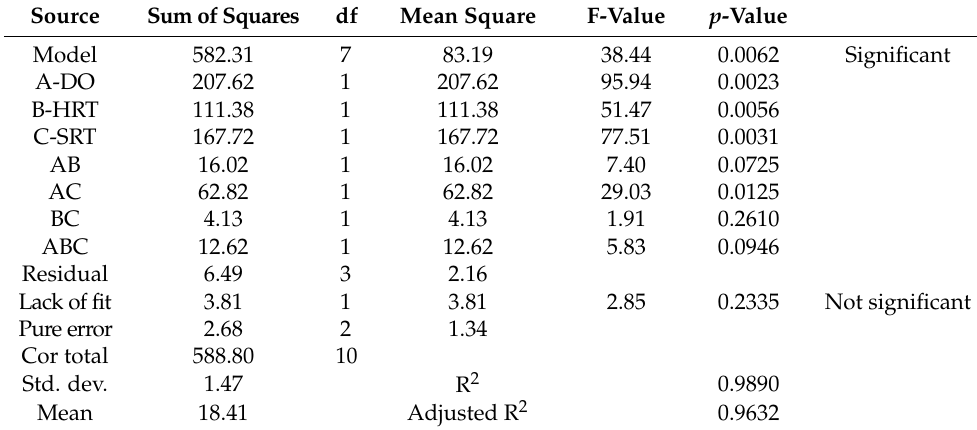
Table 4. ANOVA results for CBZ removal